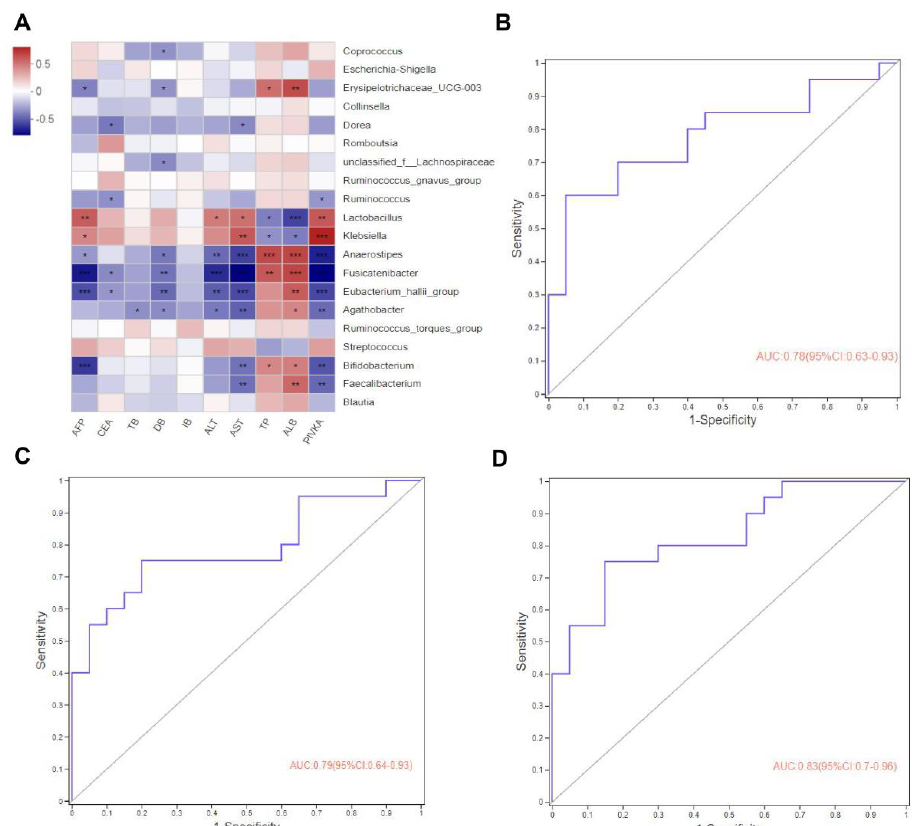
Figure 4. ( A ) The correlation test of the top 20 intestinal microbiota abundances and clinical indicators between HCC group and CON group. Clinical indicators and species are presented as the X − axis and Y − axis, respectively, and the R values and P values were obtained by calculation. R values are shown as different colors in the figure, and the color interval of different R values is presented as the legend on the right. All data were analyzed by Spearman ’ s correlation. ( B − D ) ROC diagnostic curve of gut microbes. ( B ) ROC curve of the top 4 intestinal microbiota in abundance. ( C ) ROC curve of the top 7 intestinal microbiota in abundance. ( D ) ROC curve of the top 10 intestinal microbiota in abundance. * P < 0.05, ** P < 0.01, *** P < 0.001.